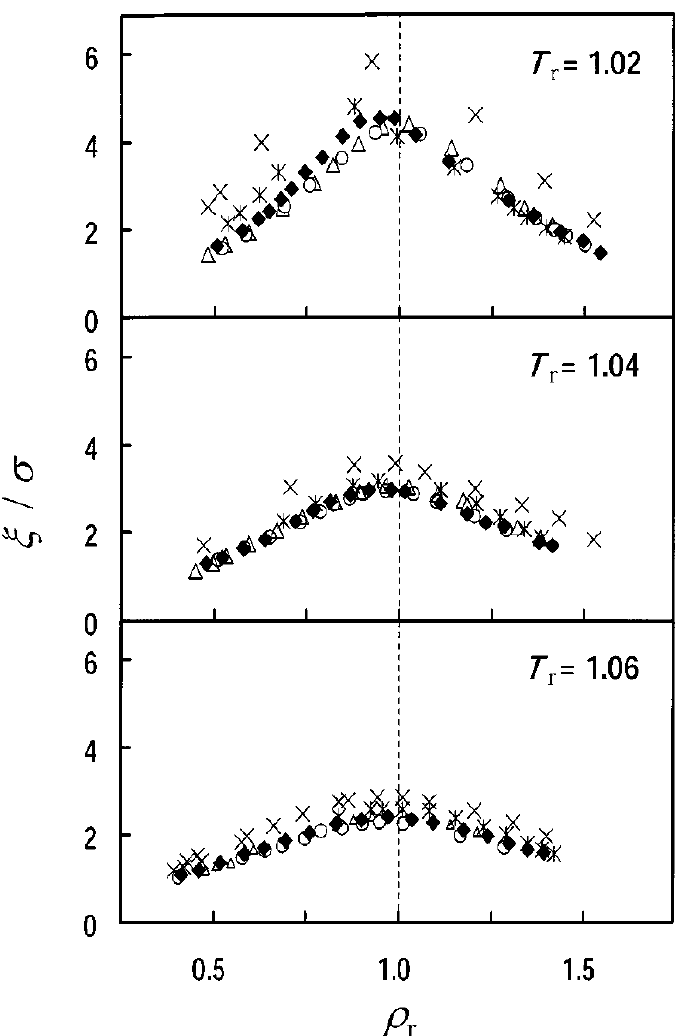
Figure 5. A comparison of the normalized correlation lengths among H 2 O (cross), CO 2 (triangle), CF 3 H (circle), C 2 H 4 (asterisk), and benzene (closed diamond) at T r = 1.02, 1.04, and 1.06. This figure is reprinted from JCP , 2003 , 119 , 1502.